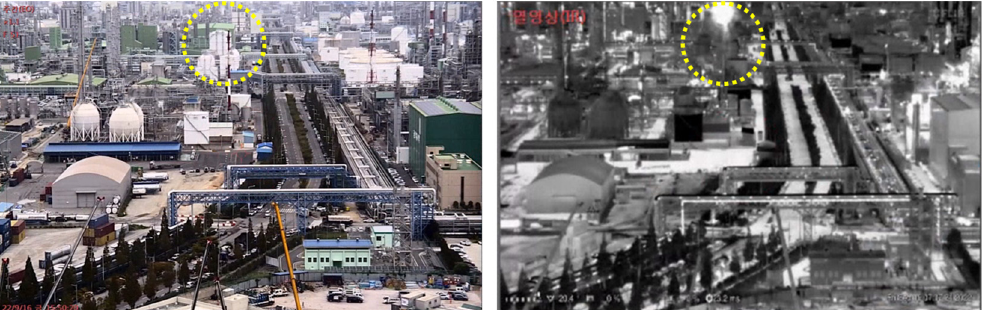
Figure 4. EO image ( left ) and IR image ( right ) of the TORUSS-LR2000 installed at the Hwachi site (Date: 16 September 2022 at 15:50 GMT+9).